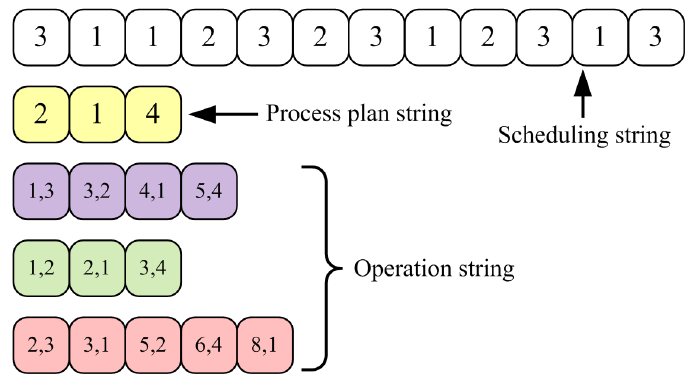
Figure 4. The coding scheme.